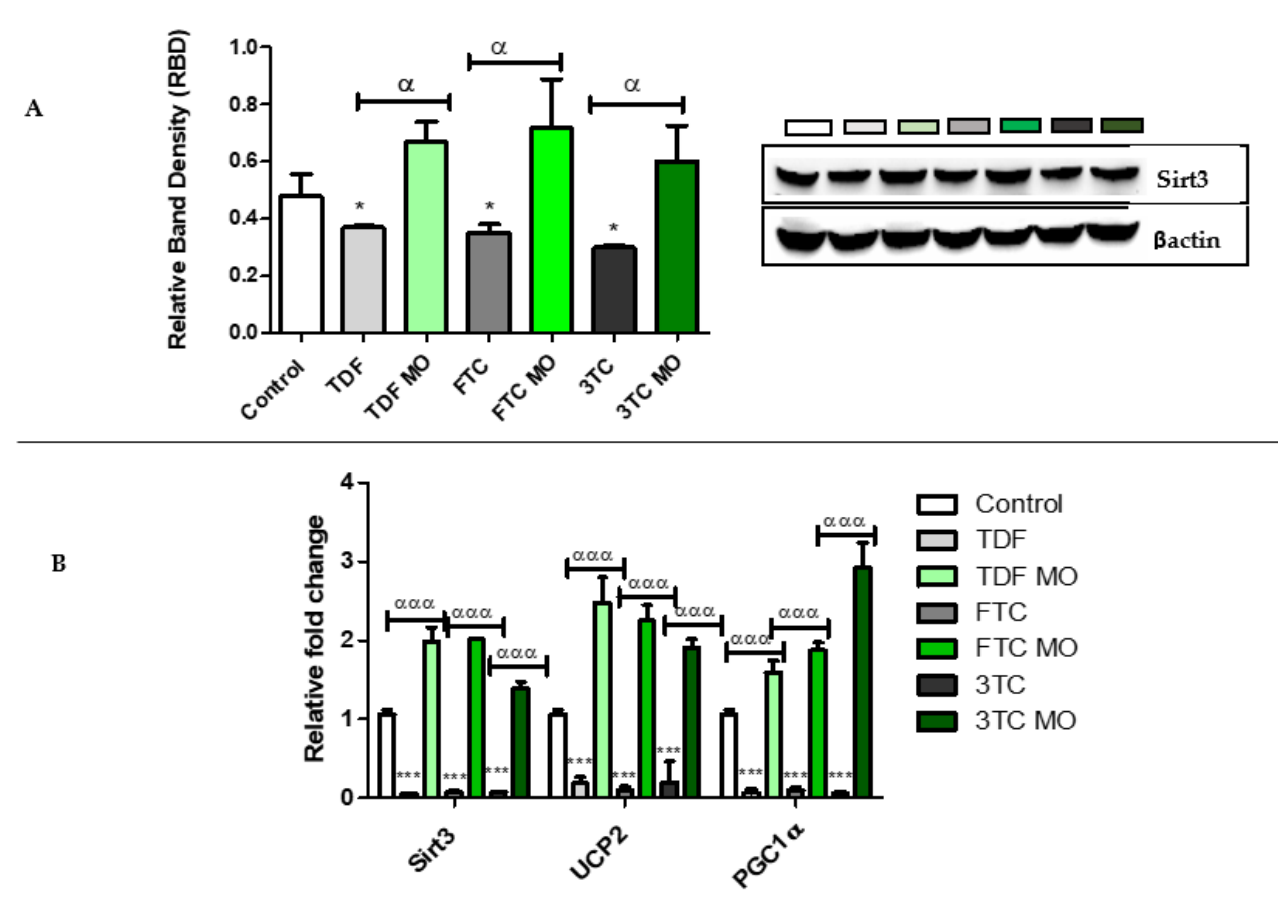
Figure 7. Assessment of mitochondrial protective enzymes expression post-ARV and post-ARV MO ( A ) Sirt3 expression was significantly decreased by TDF, FTC, and 3TC and significantly increased by ARV MO. ( B ) The mRNA of Sirt3, UCP2, and PGC1 α was significantly decreased by ARVs and increased by ARV MO. * Represents a significant difference between the control and ARV (**, p < 0.001 and ***, p < 0.0001). α Represents a significant difference between ARV and ARV MO ( αα , p < 0.001 and ααα , p < 0.0001).